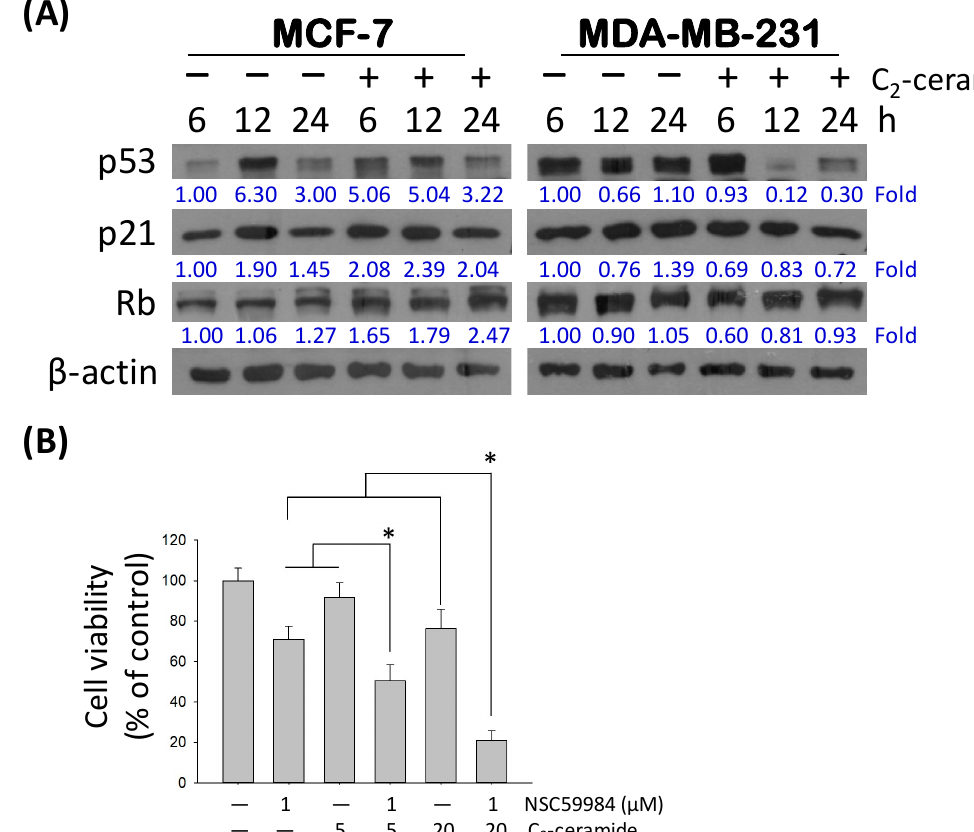
Figure 5. C 2 -ceramide-induced apoptosis-related and senescence-related signaling pathway. ( A ) The expression changes of SA- and pro-apoptotic proteins in C 2 -ceramide-treated breast cancer cells. The two breast cancer cell lines were treated with 20 µ M of C 2 -ceramide for 6, 12, and 24 h respectively. β -actin as an internal control. All fold changes were normalized by the level of internal control. ( B ) The investigation of p 53 activator NSC59984 (1 µ M) co-treated with C 2 -ceramide (5 and 20 µ M respectively) 24 h for cell viability analysis. * p < 0.05.